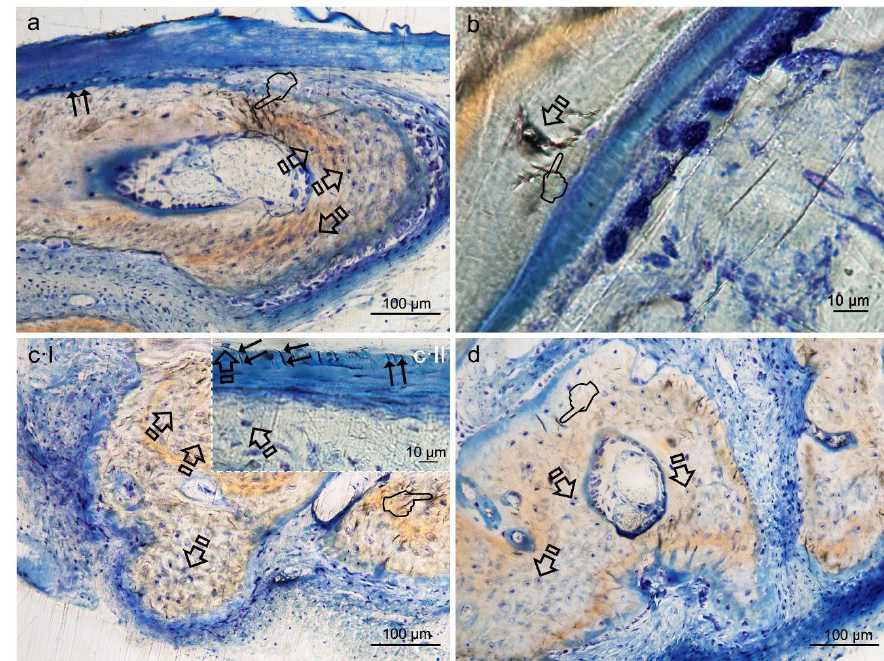
Figure 3. Bone histology obtained after using HOOC-Si ( a ), Zn-HOOC-Si ( b ), Dox-HOOC-Si ( c ) loaded membranes, and blank control (no membrane) ( d ), dyed with toluidine blue to visualize mineralized bone, at 6 weeks of healing time. Single arrows point the presence of osteocytes. Canaliculi crossed through the bone matrix to bridge up a large extend of the membranes (double arrows) (Figure 3a,(cII)). The extended network of osteocyte dendritic processes which reproduced the characteristic dendritic morphology joined at gap junctions (pointers) (Figure 3a,b,(cI),d). They were connected and intersected with each other by fine cytoplasmic processes and their branches. At high magnification, the osteocyte appeared embedded within its mineral lacuna (Figure